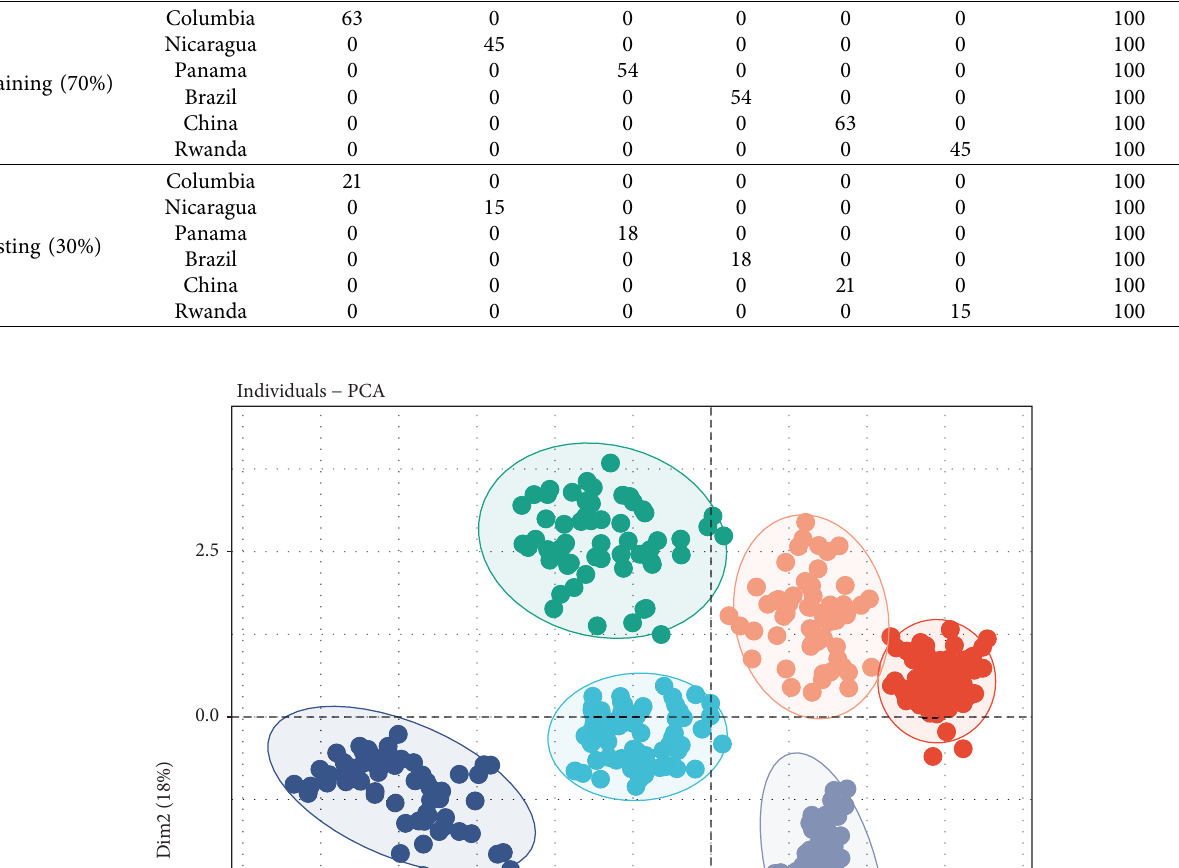
Table 10: Classifcation of mixed cofee bean samples (green, middle, and dark roasted) from six diferent original regions by RF model. Groups